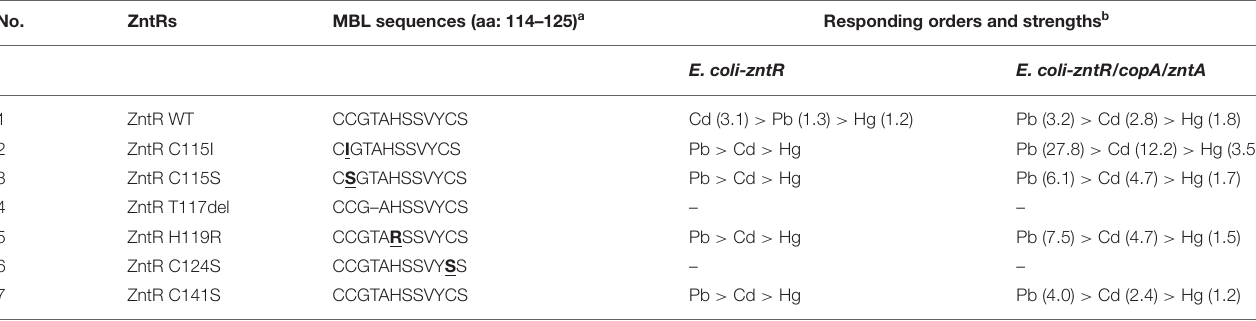
TABLE 1 | List of recombinant ZntRs tested and their responding orders toward heavy metals.